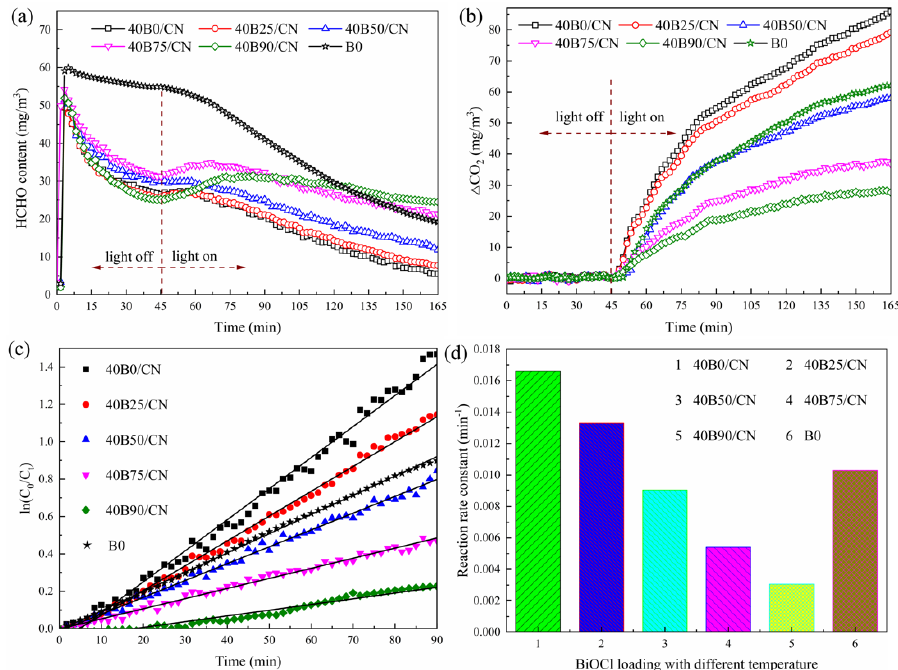
Figure 5. Variations of HCHO concentration ( a ), corresponding increased CO 2 concentration ( (cid:4574) CO 2 ) ( b ), the kinetic curves ( c ) and the reaction rate constant values ( d ) over different samples under solar light.